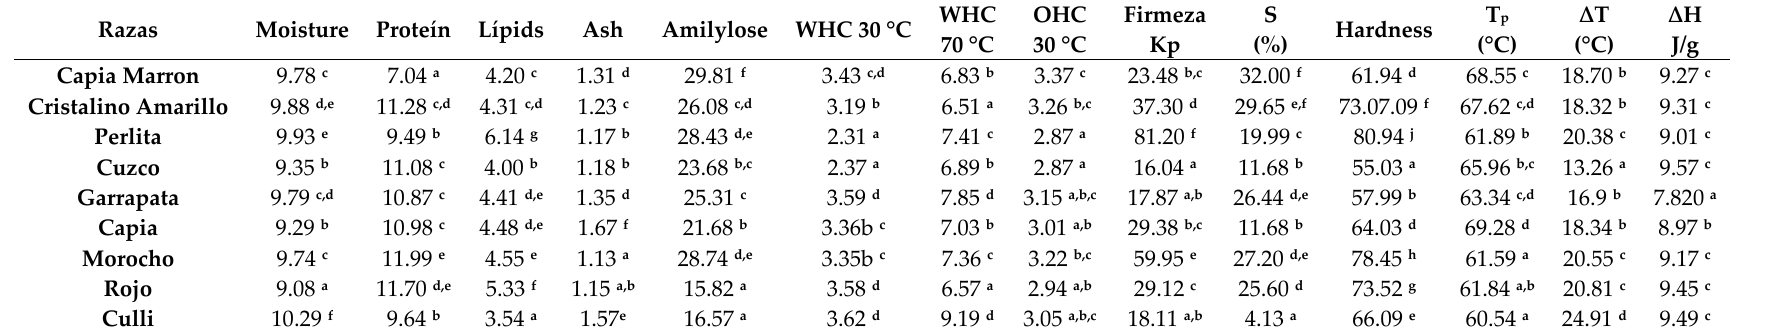
Table 2. Physicochemical and techno-functional properties of Andean